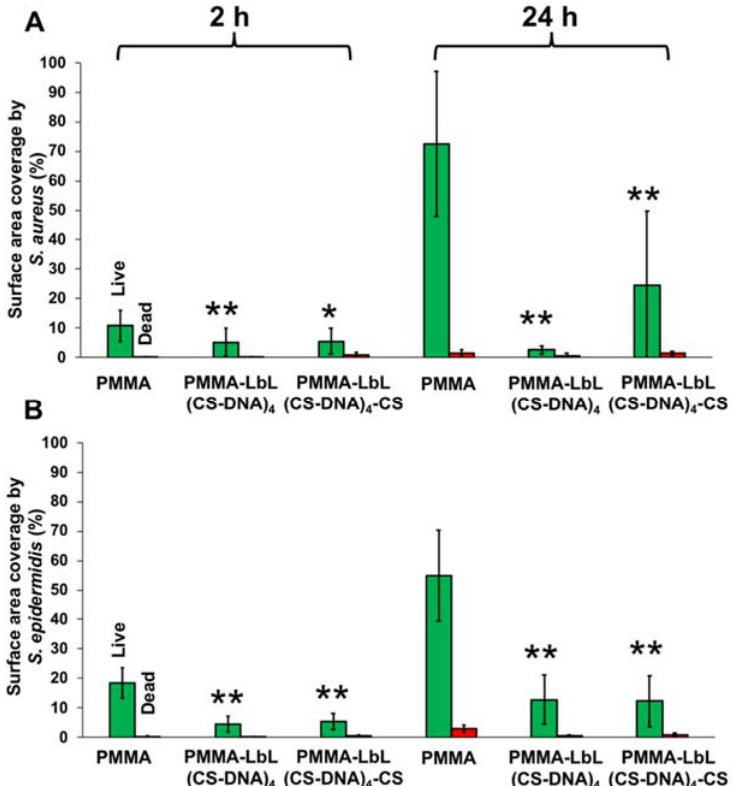
Figure 5. Surface coverage of adherent live (green bars) and dead (red bars) bacteria. ( A ) S. aureus ATCC 12598 and ( B ) S. epidermidis ATCC 35984 on uncoated and multilayer-coated PMMA surfaces after incubation at 37 °C for 2 h and 24 h. PMMA-LbL(CS-DNA) 4 has a DNA top layer, and PMMA-